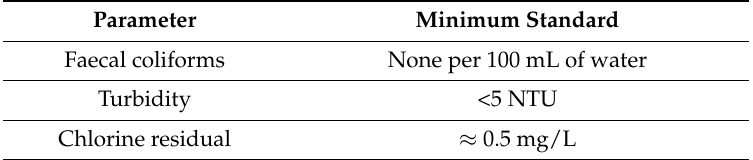
Table 3. Minimum standards for water quality in emergencies (adapted from